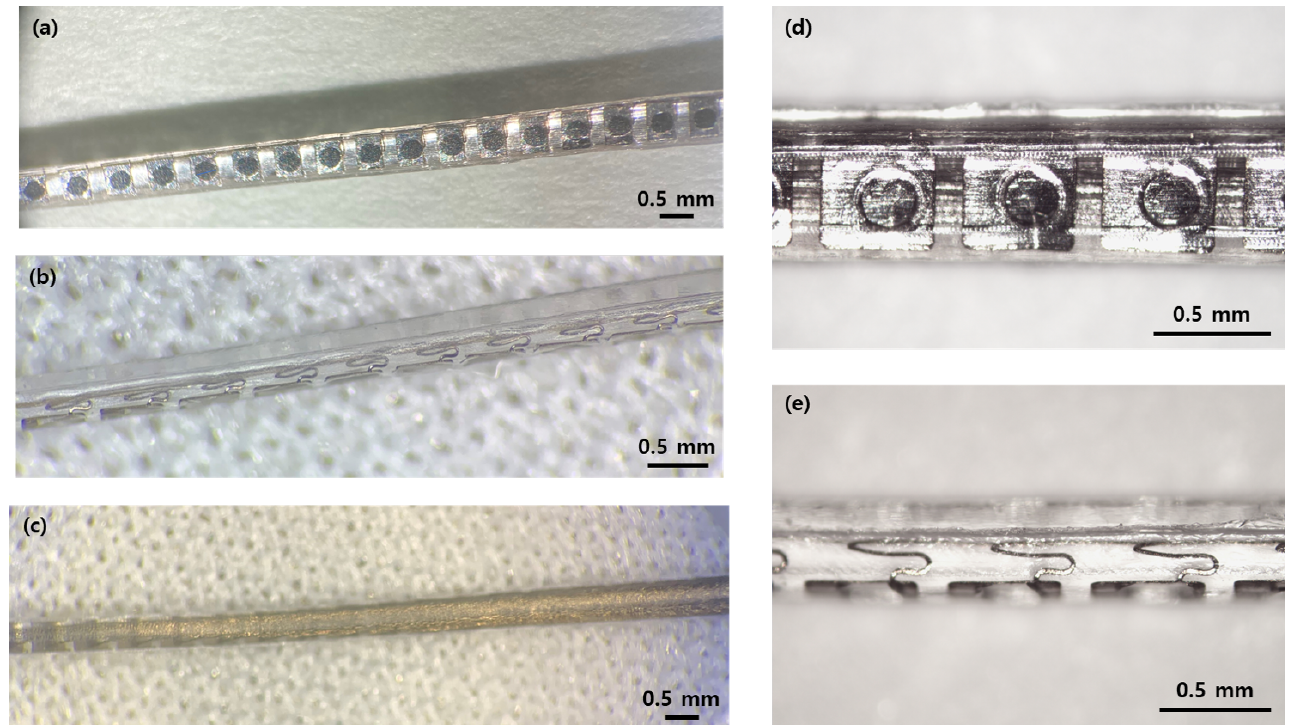
Figure 4. Manufactured 32-channel cochlear electrode array. Pictures of: ( a ) top; ( b ) side; and ( c ) bottom views of the electrode array. Enlarged pictures of ( d ) top and ( e ) side